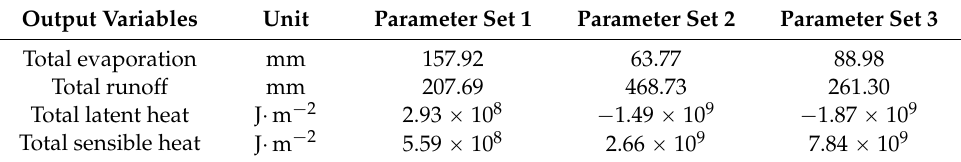
Table 7. Water and energy balance comparison for the three parameter